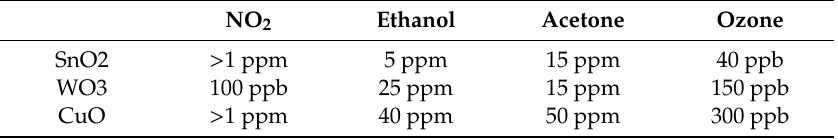
Table 1. Detection limits of the three di ff erent materials toward target chemical